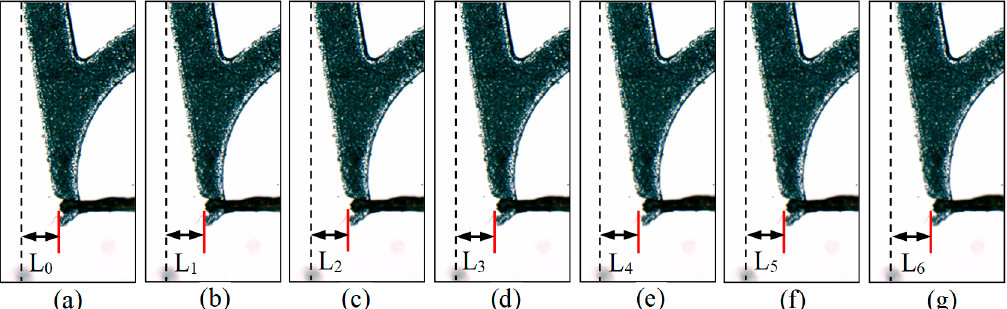
Figure 17. Results of the deformation measurement in images under different pulling force for micro-gripper’s tip. ( F ): ( a ) Deformation under F = 0 N; ( b ) Deformation under F = 0.1 N; ( c ) Deformation under F = 0.2 N; ( d ) Deformation under F = 0.3 N; ( e ) Deformation under F = 0.4 N; ( f ) Deformation under F = 0.5 N; ( g ) Deformation under F = 0.6 N.